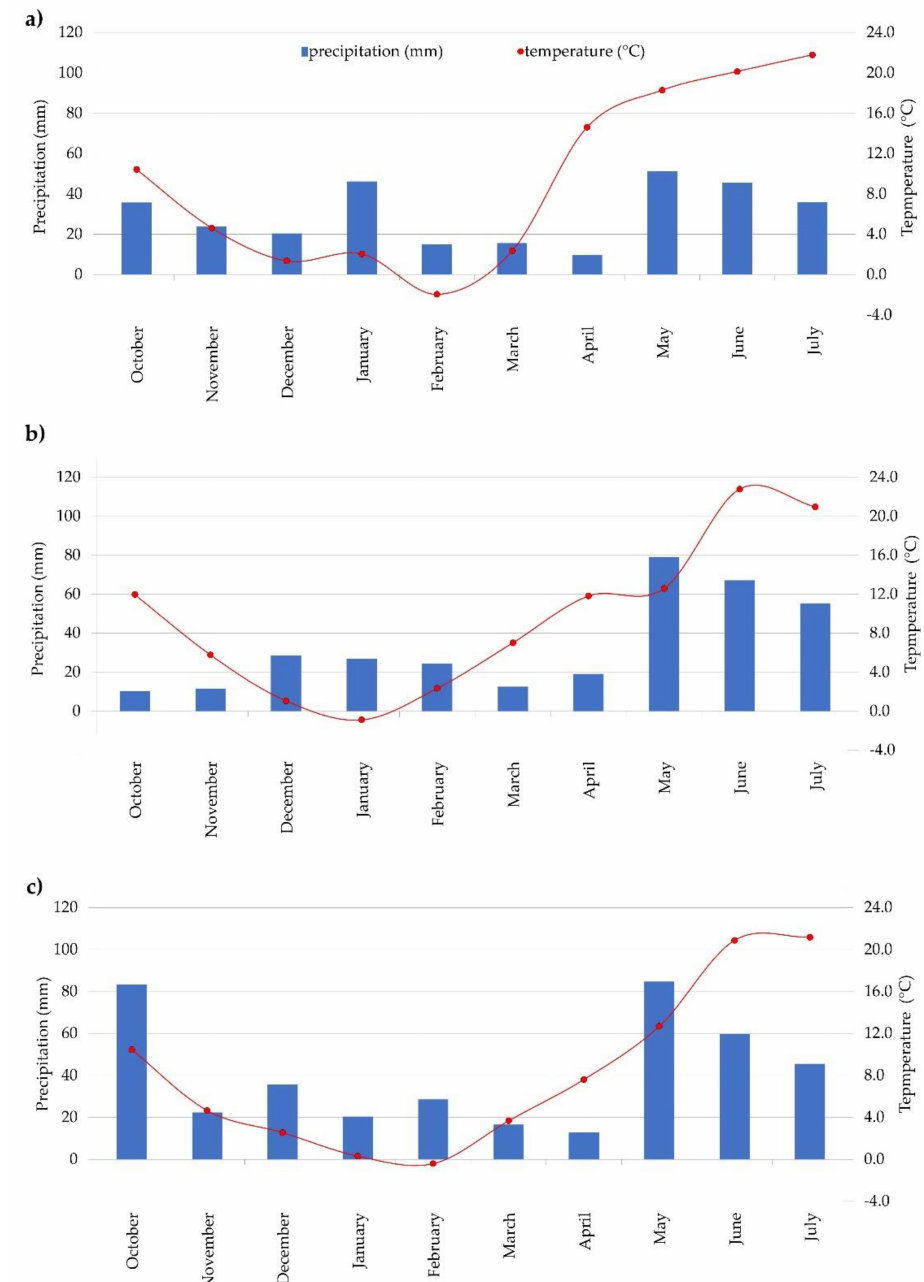
Figure 1. Weather conditions of the field experiments. ( a ) growing season 1 (2017 − 2018), ( b ) growing season 2 (2018 − 2019), ( c ) growing season 3 (2020 −